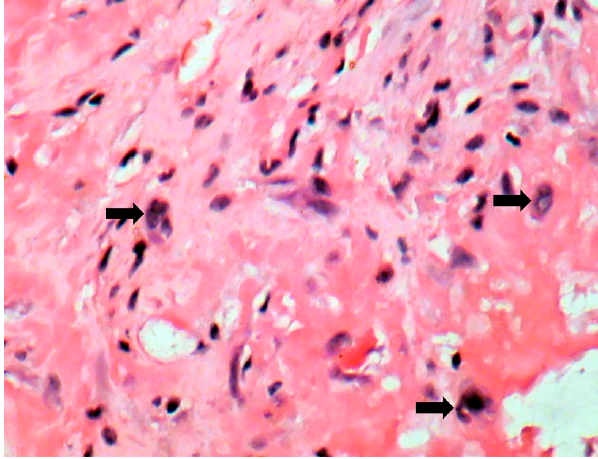
Figure 7. Giant cells (arrows) (HE stain × 40).